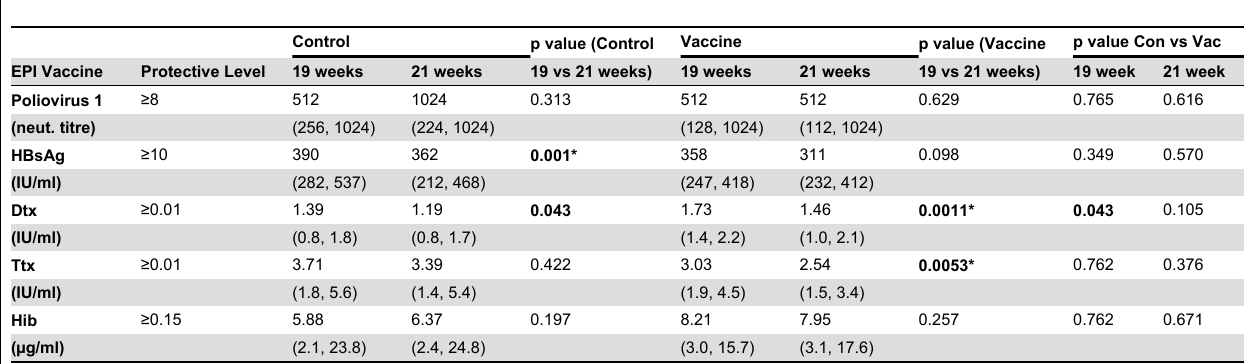
Table 5. Tested antibody titres at 19 and 21 weeks of age elicited by EPI vaccines.